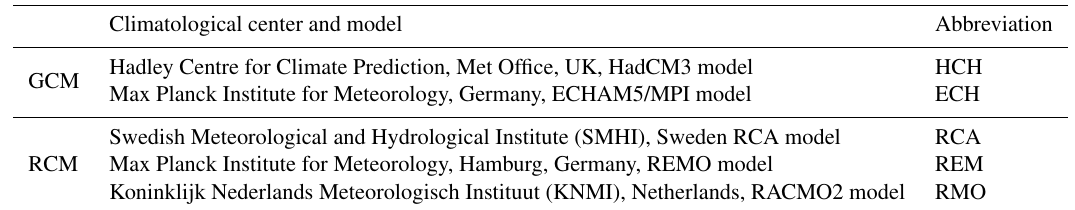
Table 2. List of global and regional climate models used in this work. The four GCM–RCM combinations used are ECH-RCA, ECH-REM, ECH-RMO, and